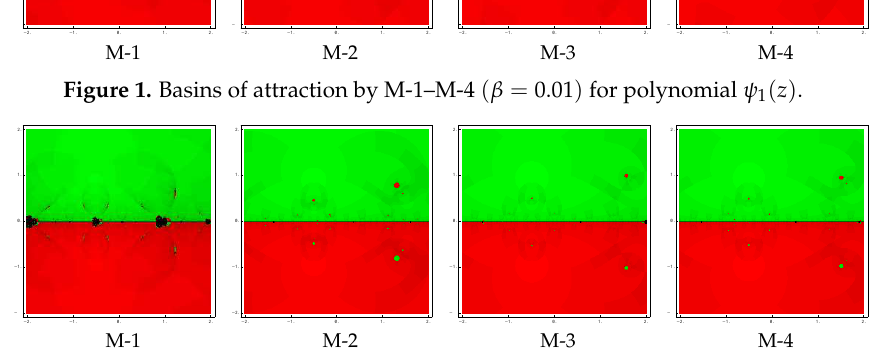
Figure 1. Basins of attraction by M-1–M-4 ( β = 0.01 ) for polynomial ψ 1 ( z ) .